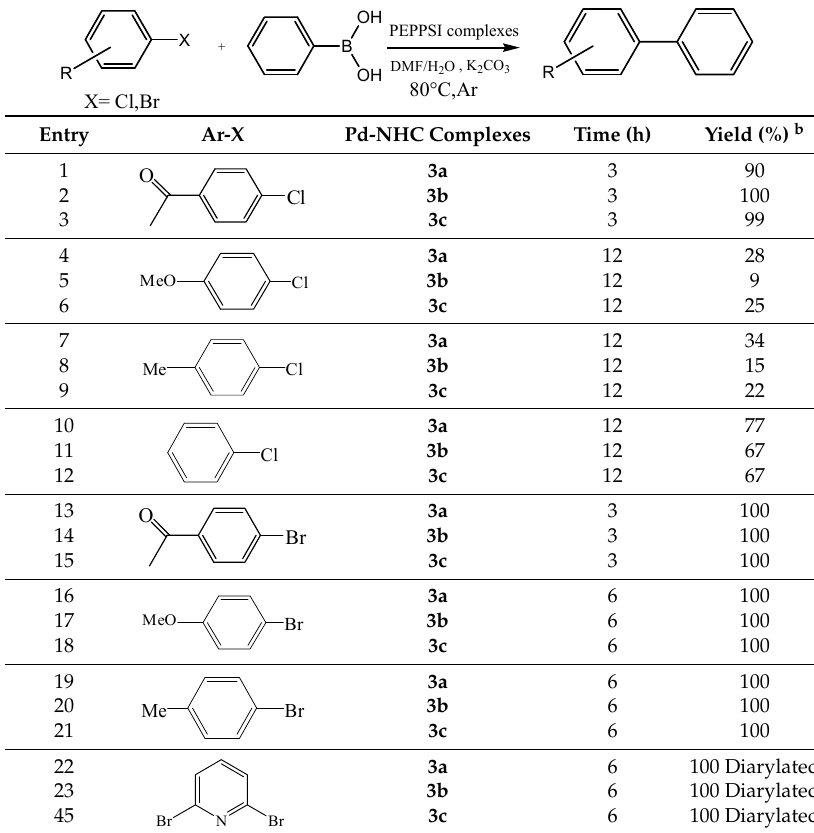
Table 3. The Suzuki Coupling Reaction of Aryl Chlorides/Bromides with phenylboronic Acid catalyzed by different unsymmetrical PEPPSI complexes a .